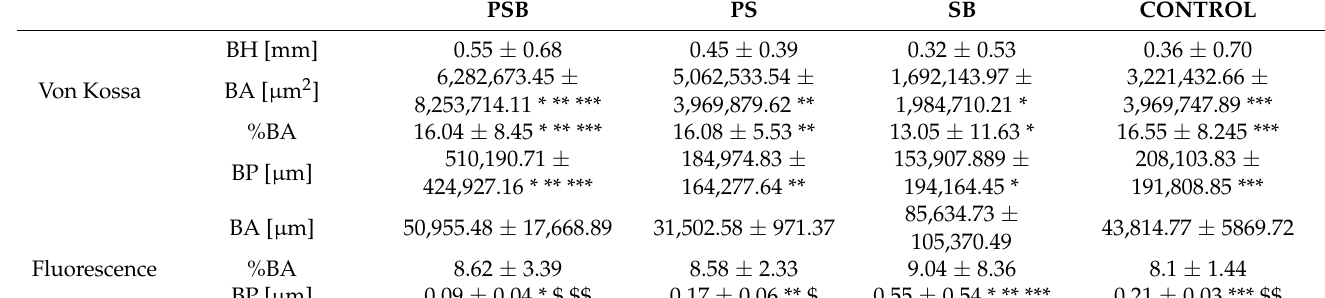
Table 3. Histological results after 3 weeks (BH, bone height; BA, Bone area; BP, Bone perimeter. The statistically significant differences are shown in the same row by pairs of similar symbols (*, **, ***, $, $$; p < 0.05).